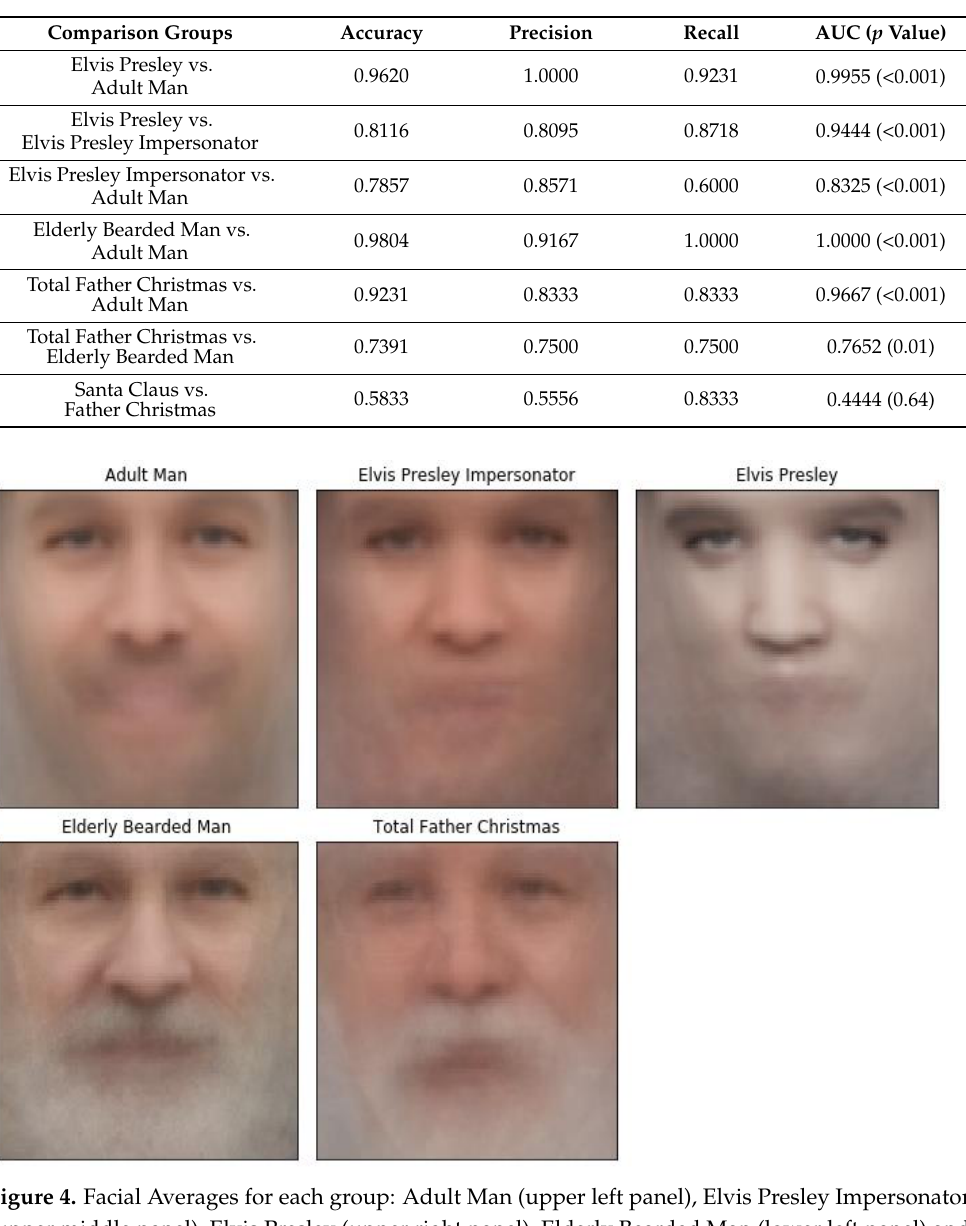
Table 5. Accuracy, precision, recall and AUC for SVM classifiers for study group comparisons.